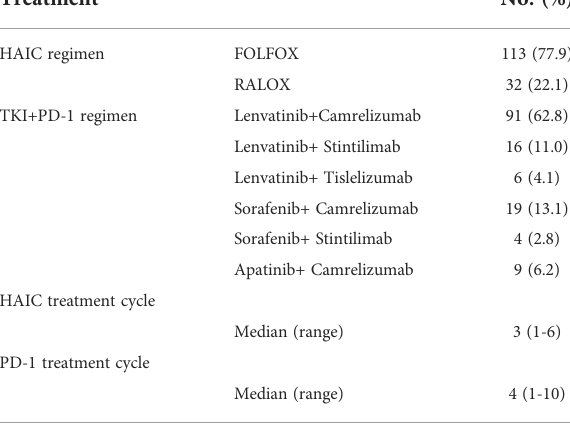
TABLE 2 Regimens of the triple combination